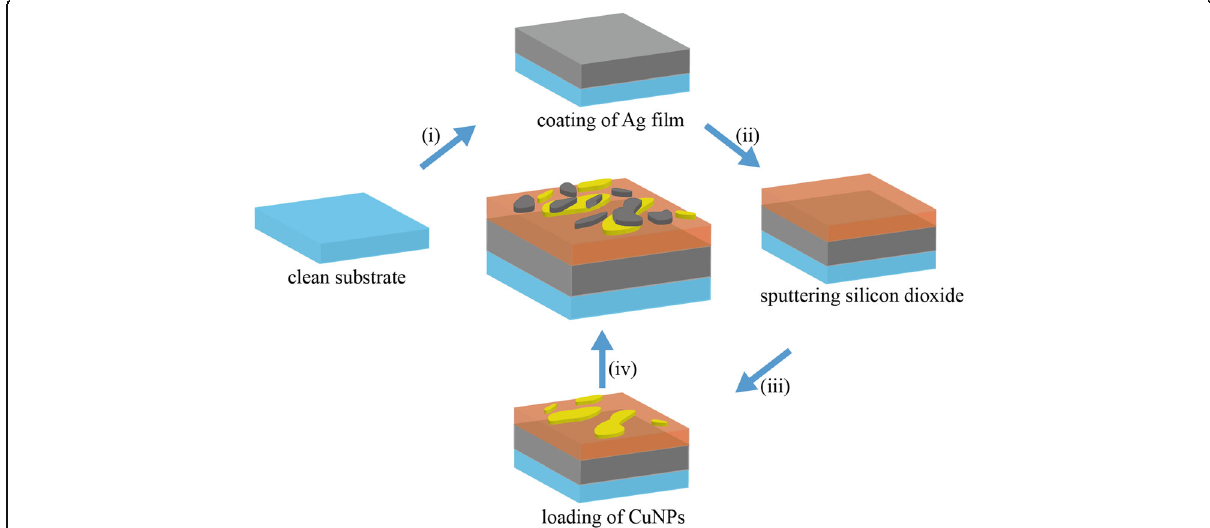
Fig. 1 Schematic illustration of steps taken to fabricate the absorber which consists of silver and copper nanoparticles deposited on the surface: (i) coating of Ag film for counter-transmission, (ii) sputtering silicon dioxide, (iii) deposited a layer of copper particles by electron beam evaporation system, (iv) loading of Ag NPs by